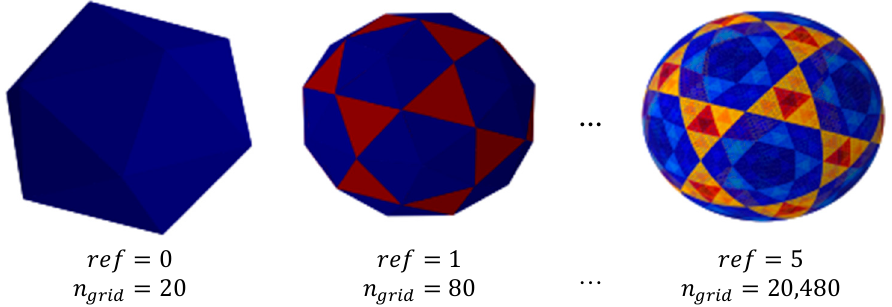
Figure 3. Evolution of icosphere with refinement level 0, 1, and 5. The color represents the relative area of the triangles.